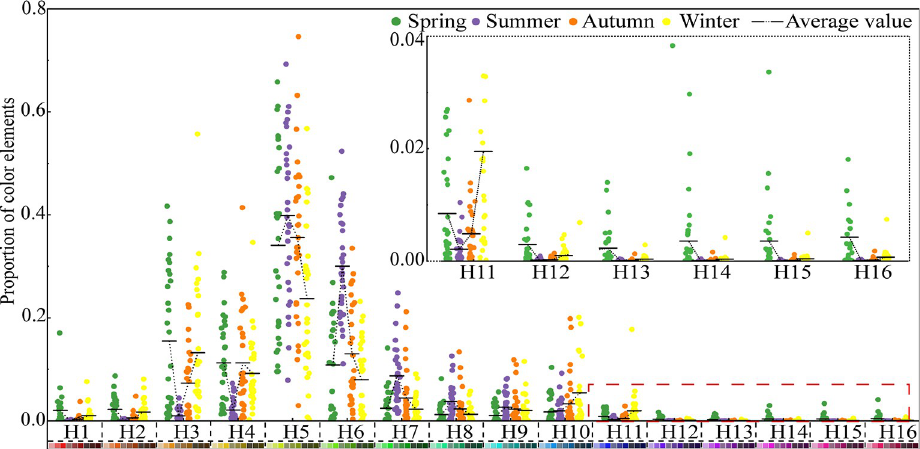
Fig 3. Proportion of color elements in spring, summer, autumn, and